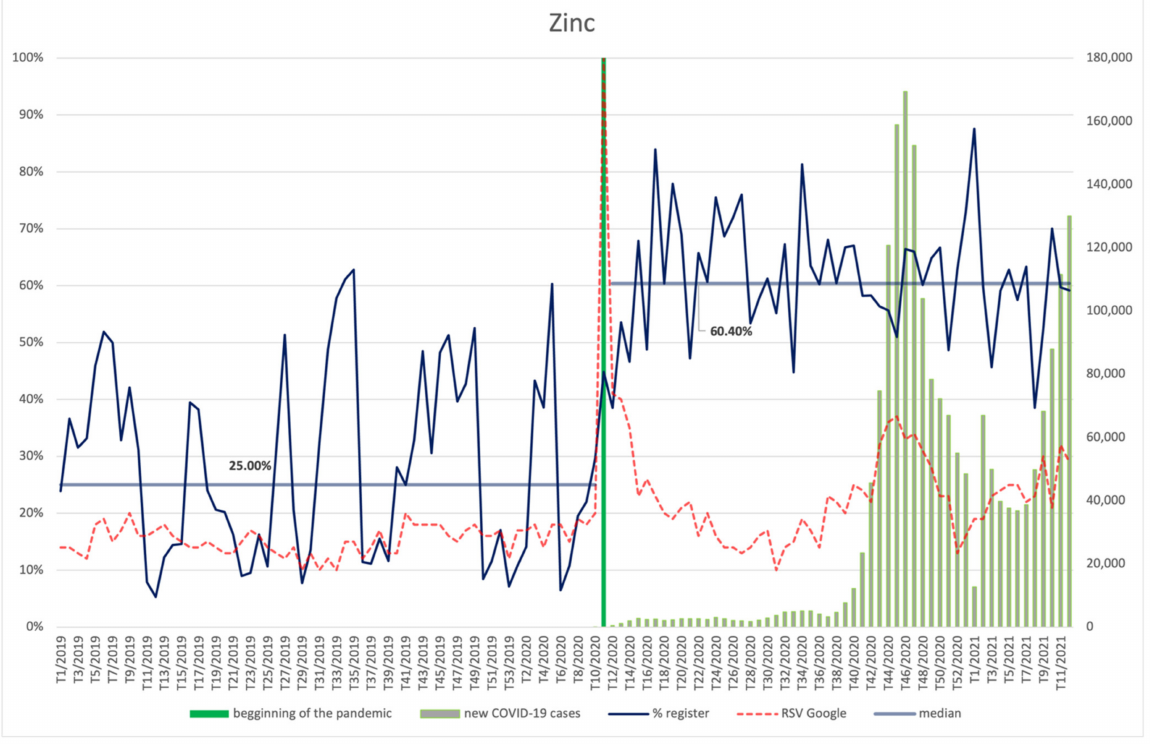
Figure 8. Comparison between the number of new registrations of products containing zinc, the number of COVID-19 cases, and the frequency of search for information on the ingredient in the Google